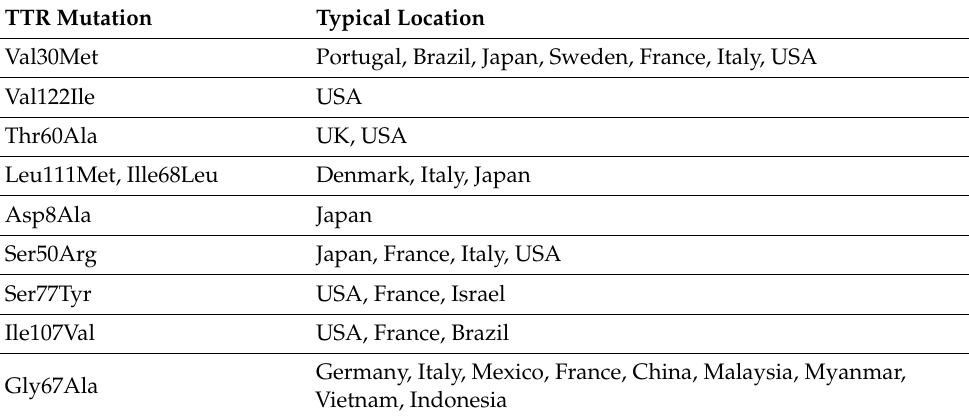
Table 2. Specific TTR mutations and epidemiology [12].